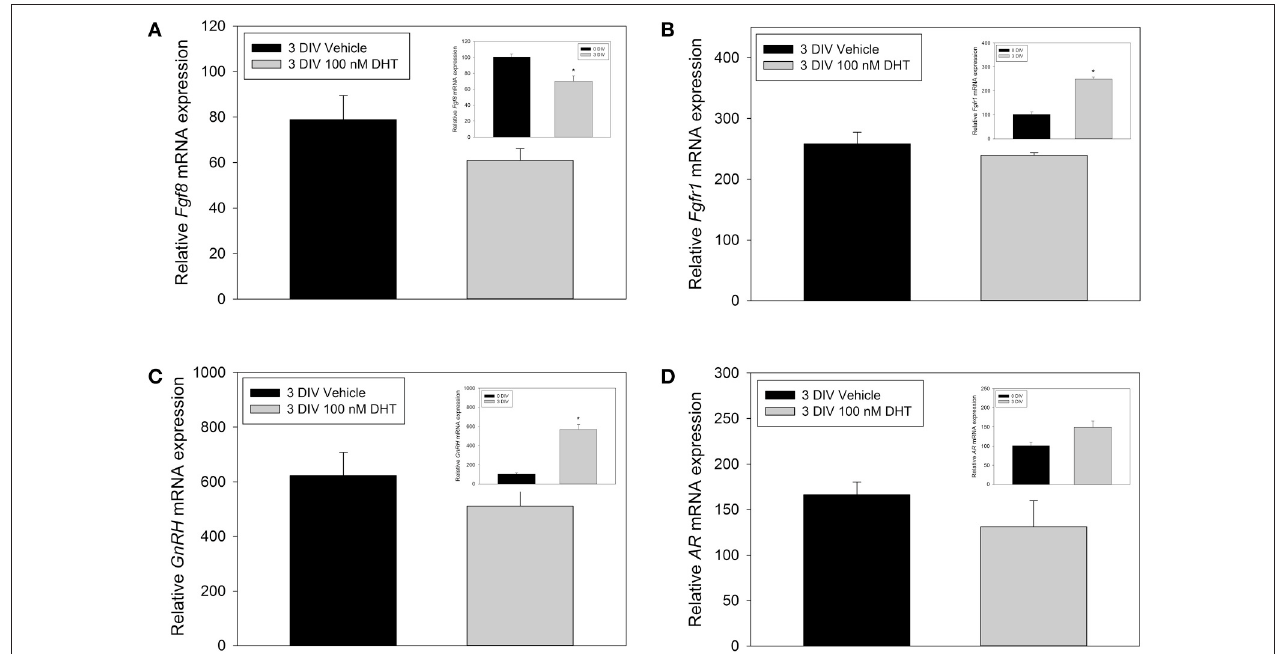
FIGURE 4 | RT-qPCR for Fgf8 , Fgfr1, GnRH, AR mRNA nasal explants treated for 3DIV with vehicle ( n = 3 ) or 100nM DHT ( n = 3 animals) (A–D). Inset panels represent comparisons between 0DIV ( n = 3 ) vs. collapsed 3DIV nasal explant expression data ( n = 6 ), which showed that Fgf8 mRNA significantly decreased (A) , Fgfr1 mRNA signifigantly increased (B) , GnRH mRNA signifigantly increased (C) , and no significant difference in AR mRNA expression (D) after 3DIV. * p < 0.05